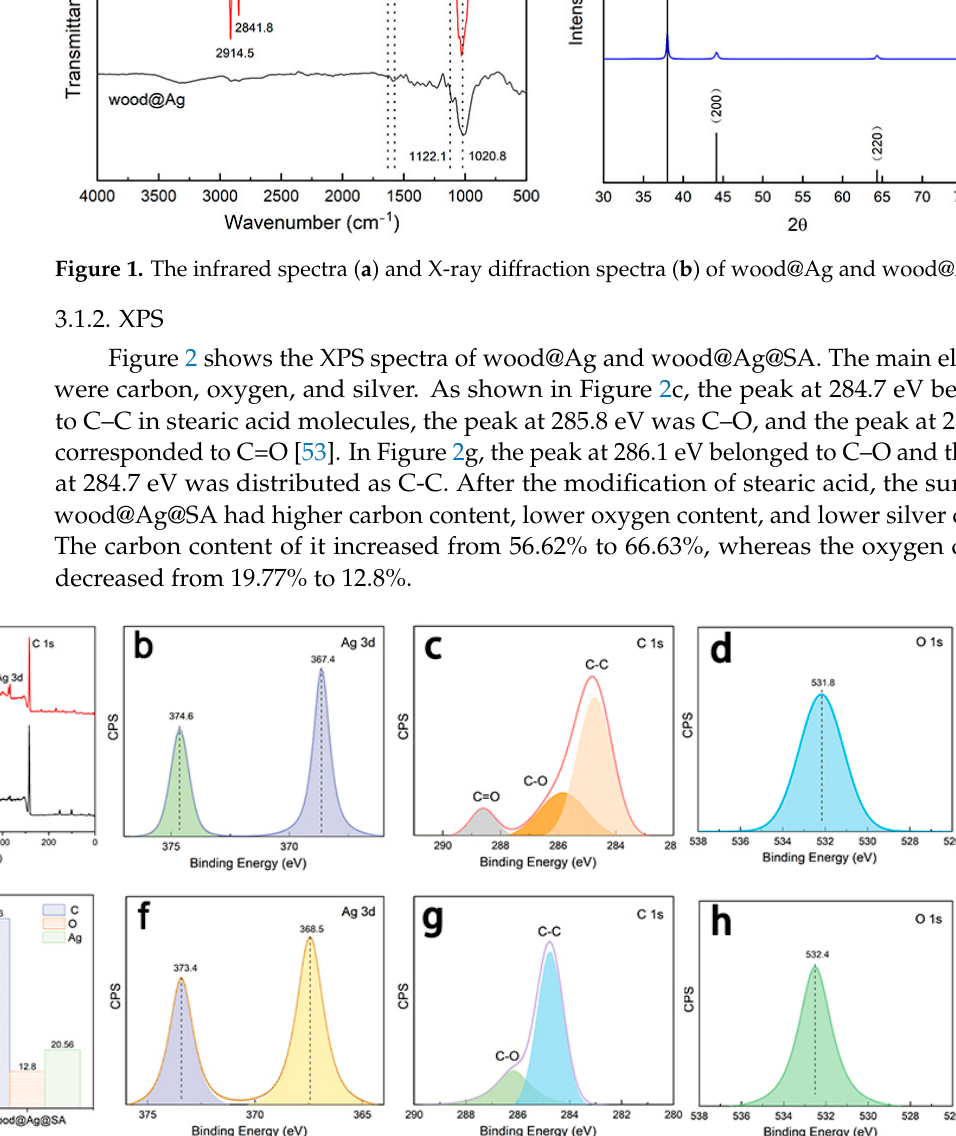
Figure 1. The infrared spectra ( a ) and X-ray diffraction spectra ( b ) of wood@Ag and wood@Ag@SA.